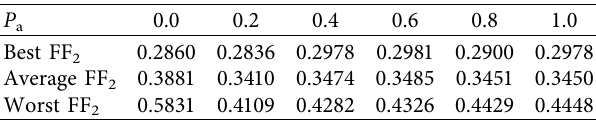
Table 2: The obtained results by ICOA for Case 2 of the IEEE 33- bus distribution